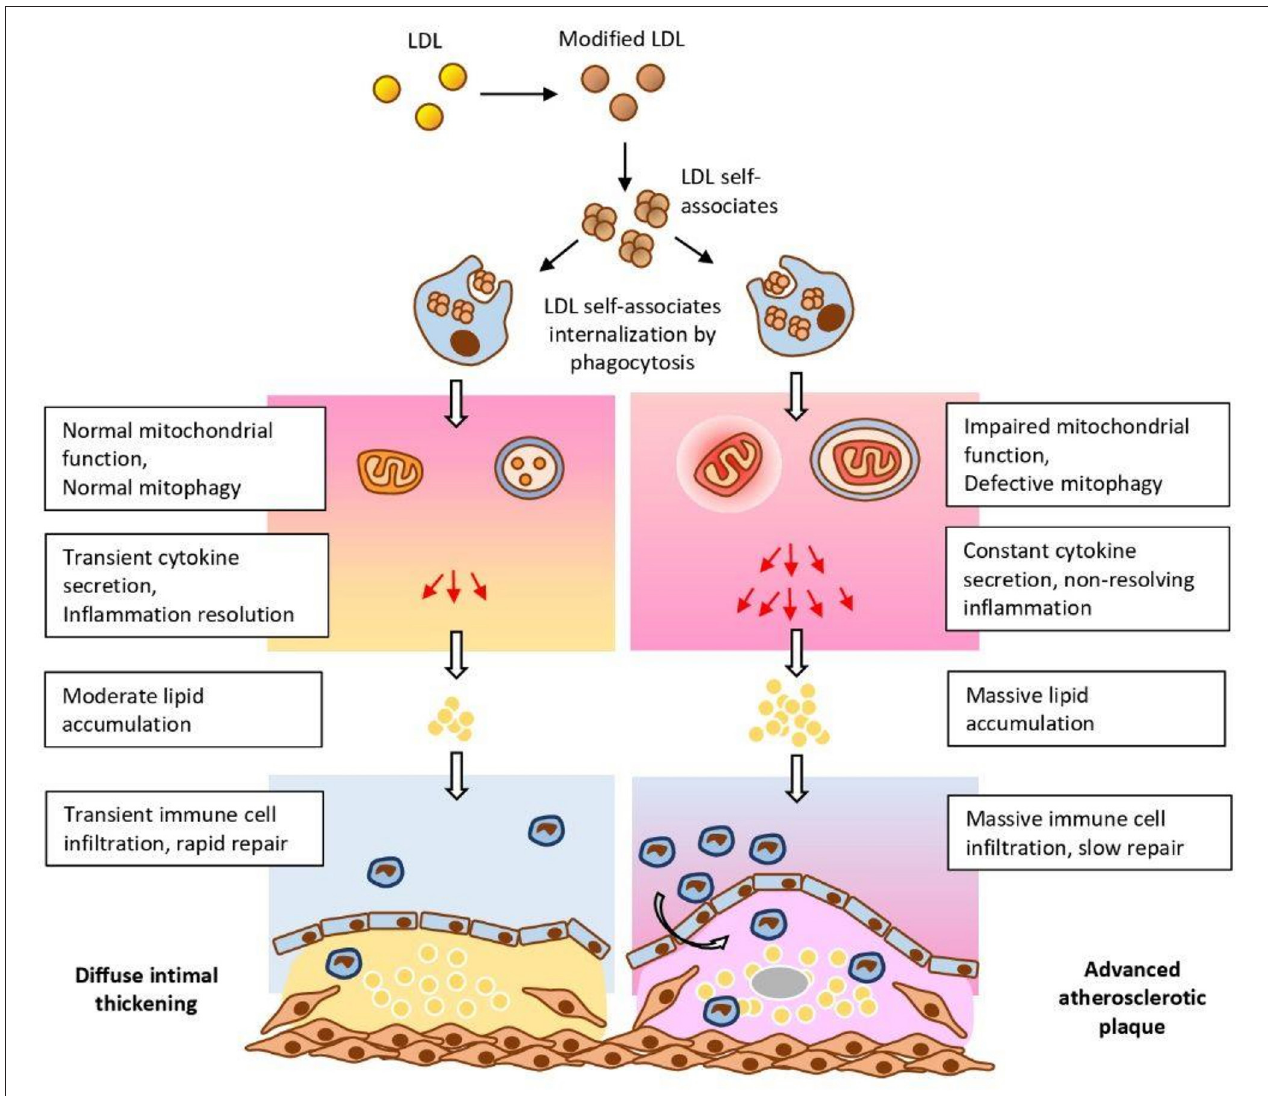
FIGURE 1 | The influence of mtDNA mutations on the development of atherosclerosis. Mutations may enhance modified LDL-induced lipid accumulation in arterial walls by stimulation of innate immune responses, and, as a result, the establishment of non-resolving inflammation ( 1) [the figure was borrowed from the publication